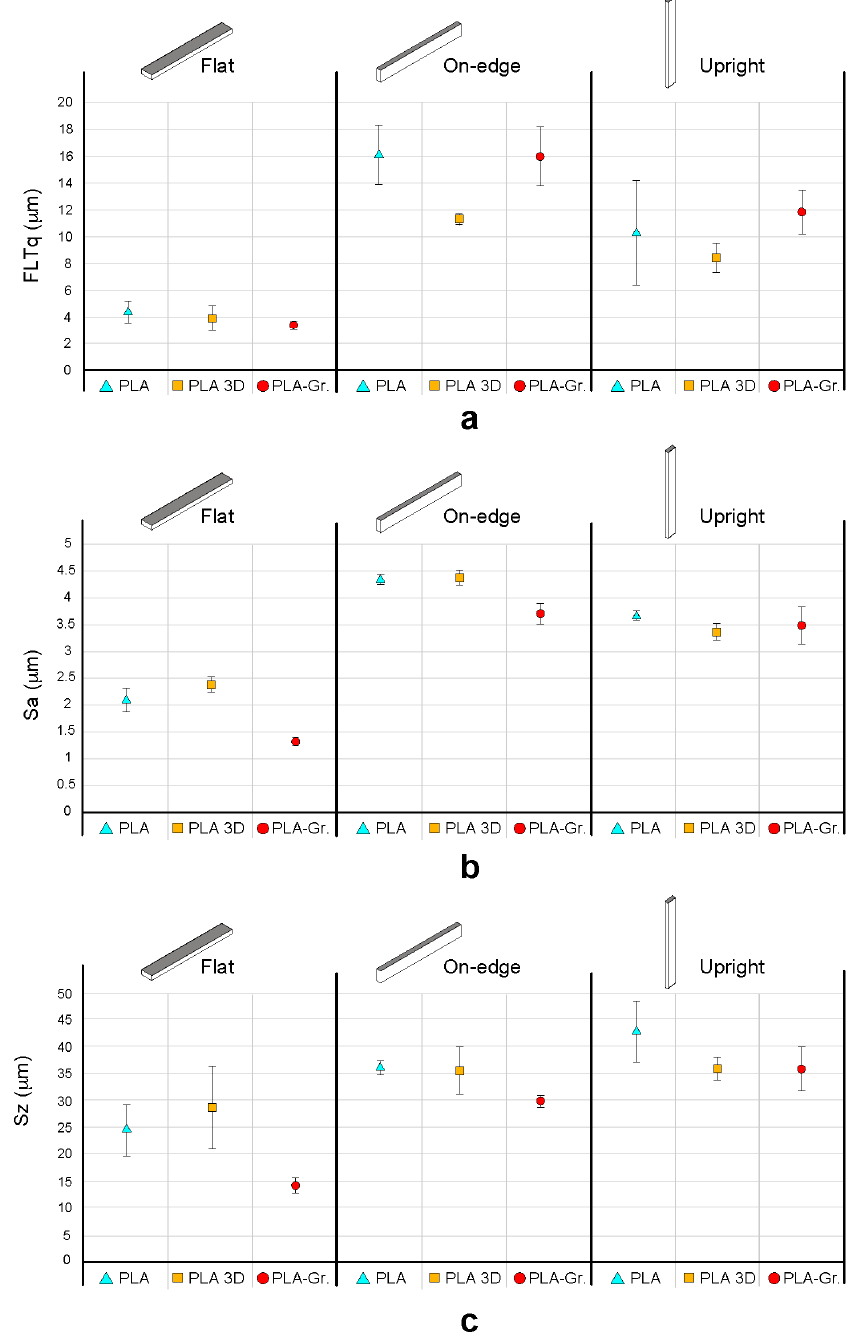
Figure 11 . Surface texture results of PLA-based samples as a function of build orientation and the type of material. The results of three samples of each set are shown for comparative purposes: ( a ) Root mean square flatness deviation (Fltq), ( b ) Arithmetic mean height (Sa), ( c ) Maximum height (Sz).